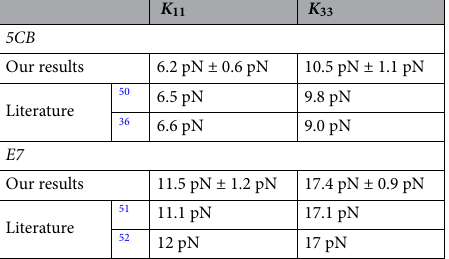
Table 1. Comparison of our results from experimentally measured data to the values published in the